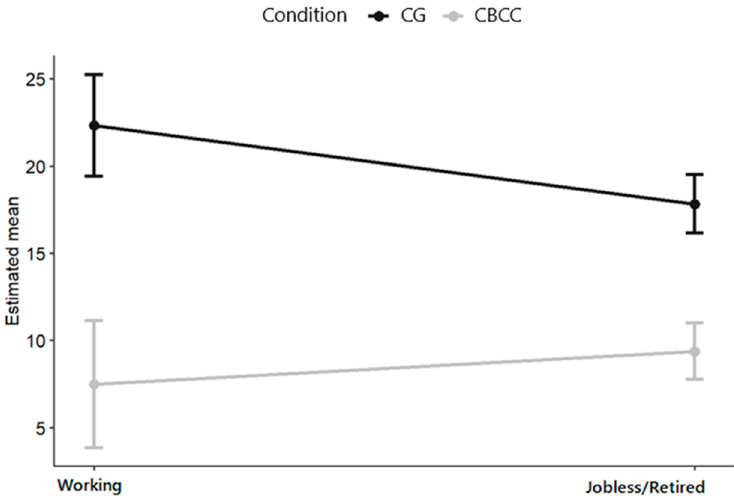
Figure 4. Plot of the e ff ect of the interaction between main economic activity and group on the change in depressive symptoms between the pre-intervention time point and 12-month follow-up.